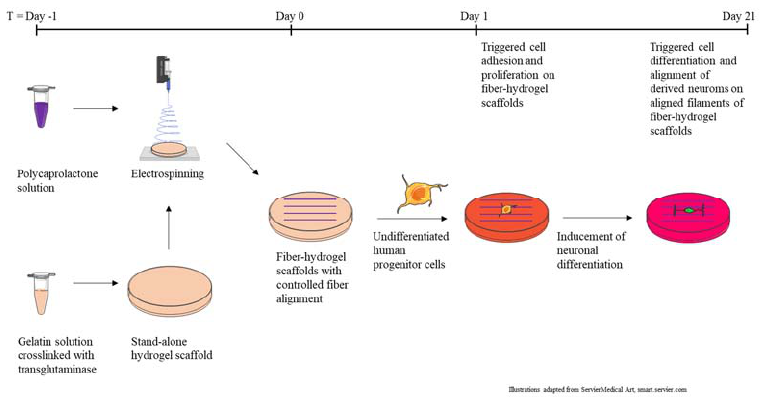
Figure 1. Production process of fiber–hydrogel scaffolds and use in cell culture experiments.